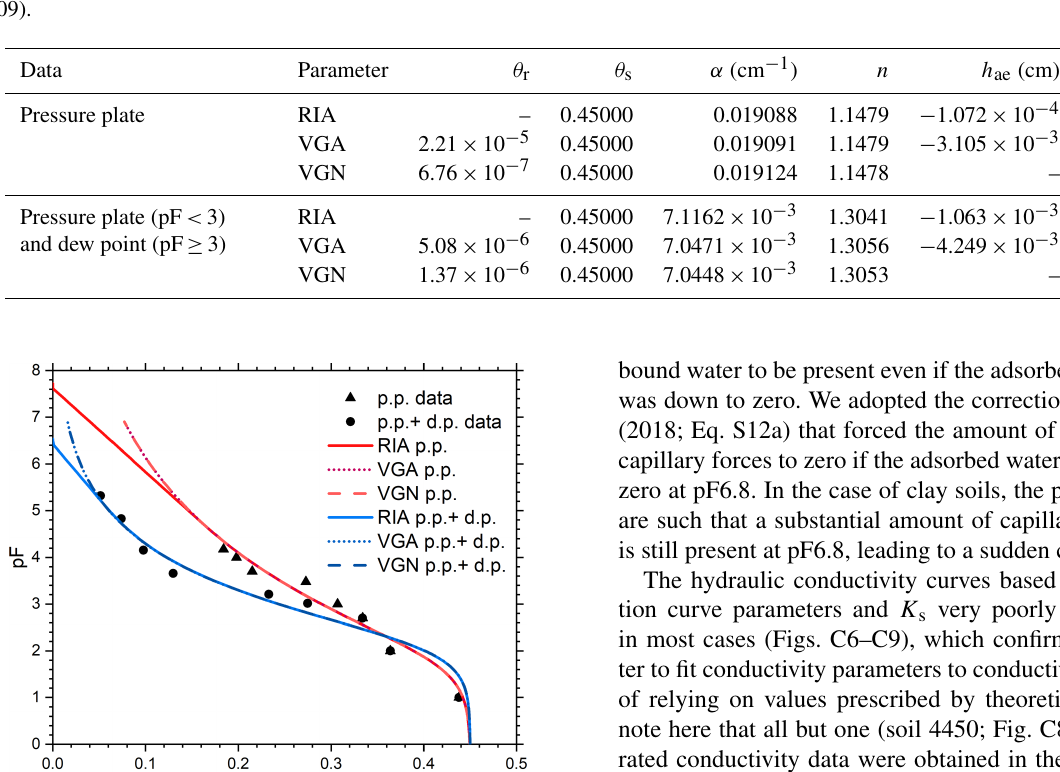
Table 3. Parameters of the fit to the pressure plate data and a combination of the pressure plate and dew point data of Bittelli and Flury (2009).